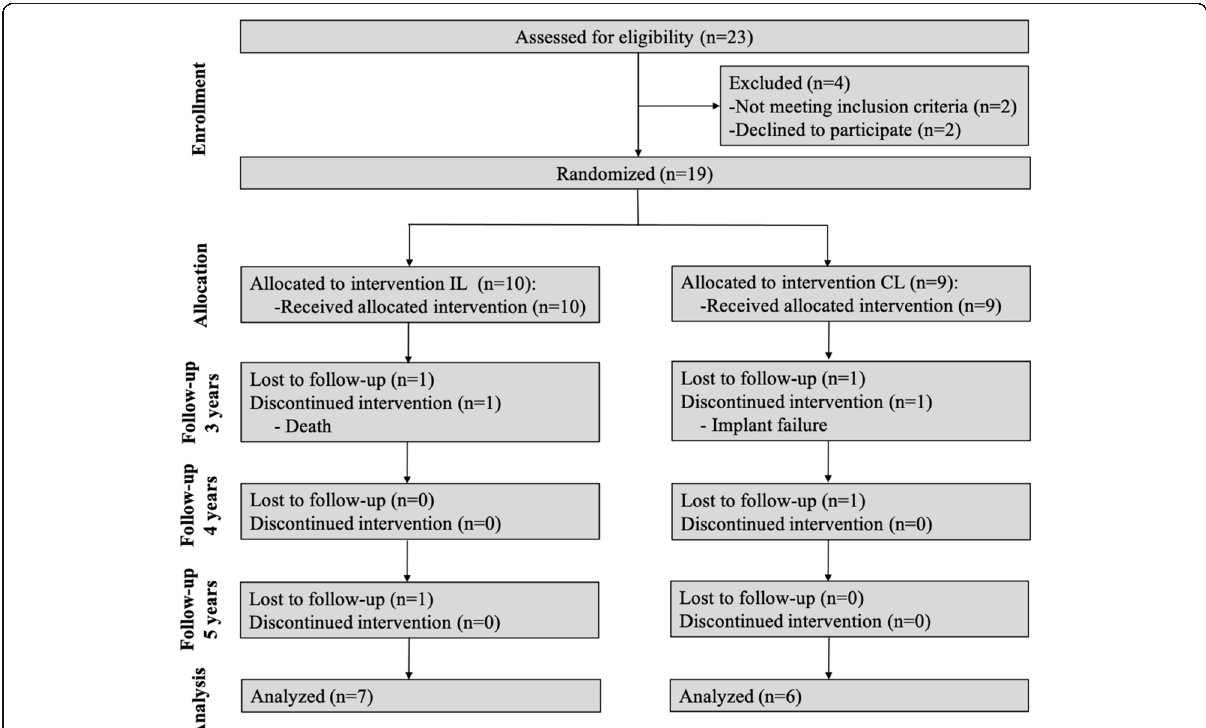
Fig. 1 CONSORT flow diagram of participants enrollment, intervention, follow-up, and data analyses in the immediate loading group compared with the conventional loading